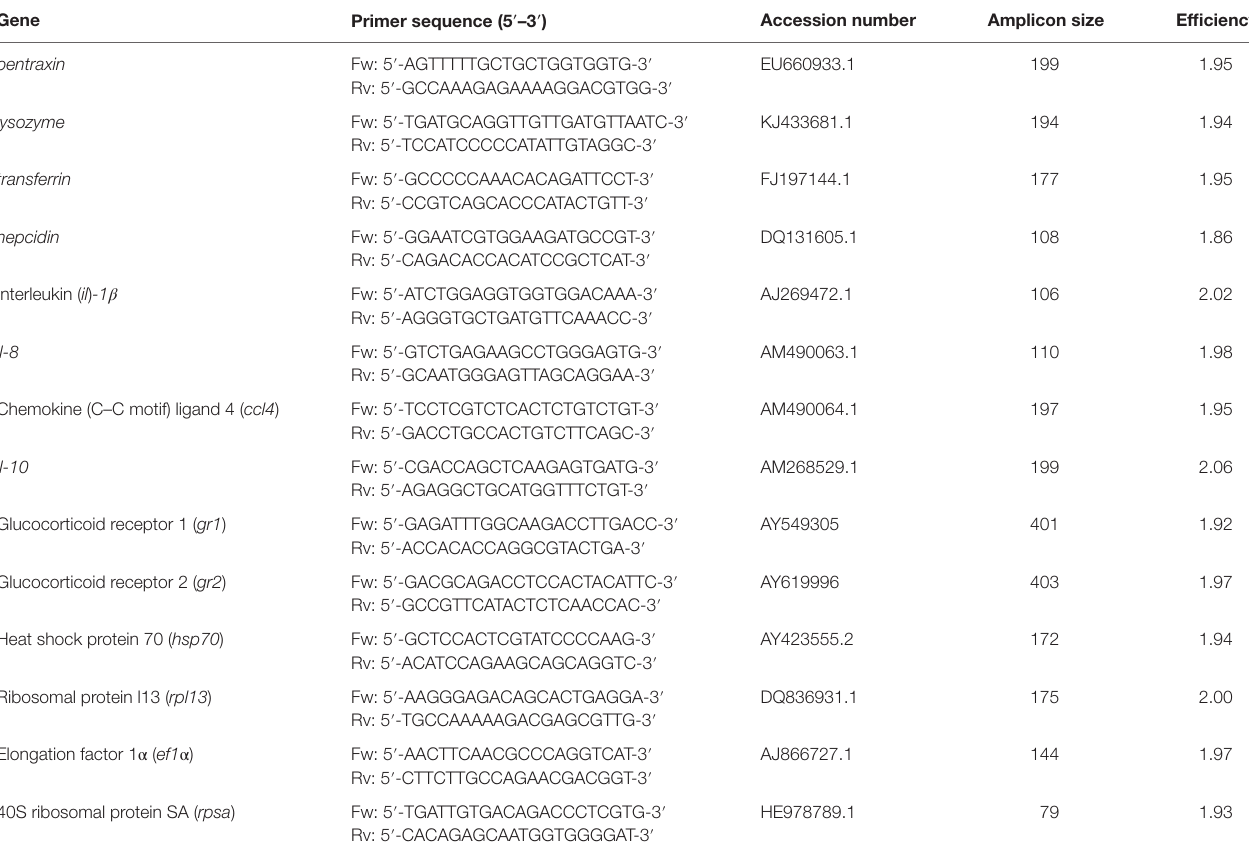
TaBle 1 | Primers used in real-time PCR for gene expression analysis. gene Primer sequence (5 ′ –3 ′